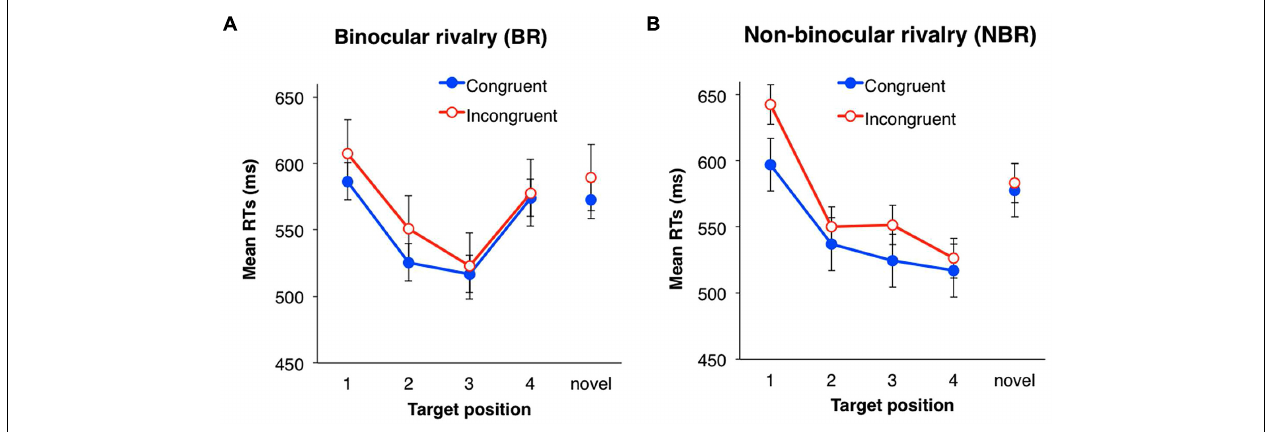
FIGURE 4 | Mean RTs of target detection in Experiment 2. (A) Binocular rivalry (BR) condition. (B) Non-binocular rivalry (NBR) condition. Filled circles (blue) indicate the mean RTs in the congruent eye condition; open circles (red) indicate the mean RTs in the incongruent condition. Error bars represent SE.